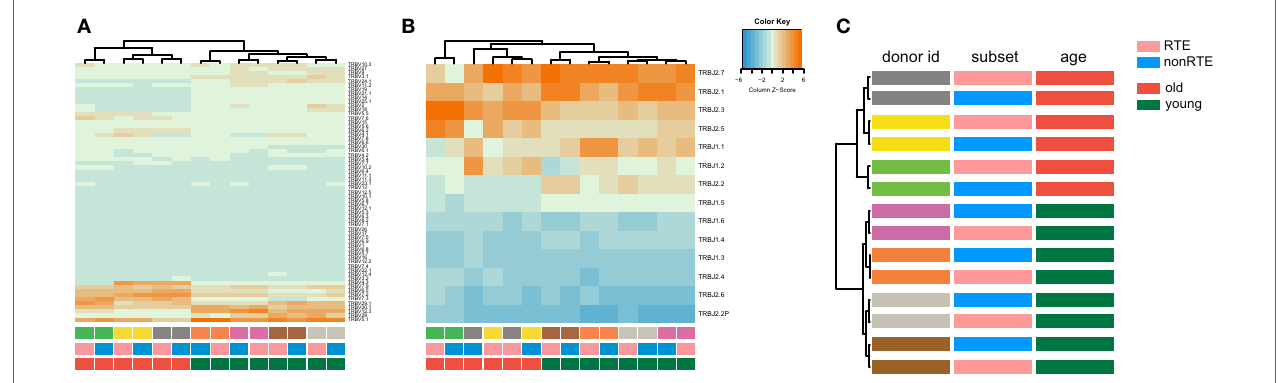
FigUre 6 | TRBV and TRBJ gene segment usage in recent thymic emigrant-enriched and mature naïve CD4 T cells of young and old individuals. (a) Heatmap and hierarchical clustering dendrogram for weighted TRBV usage. (b) Weighted TRBJ usage. (c) Hierarchical clustering of TRBV–TRBJ combination frequency (Jensen–Shannon divergence is used as metric). Note that repertoires of young and old individuals cluster separately.